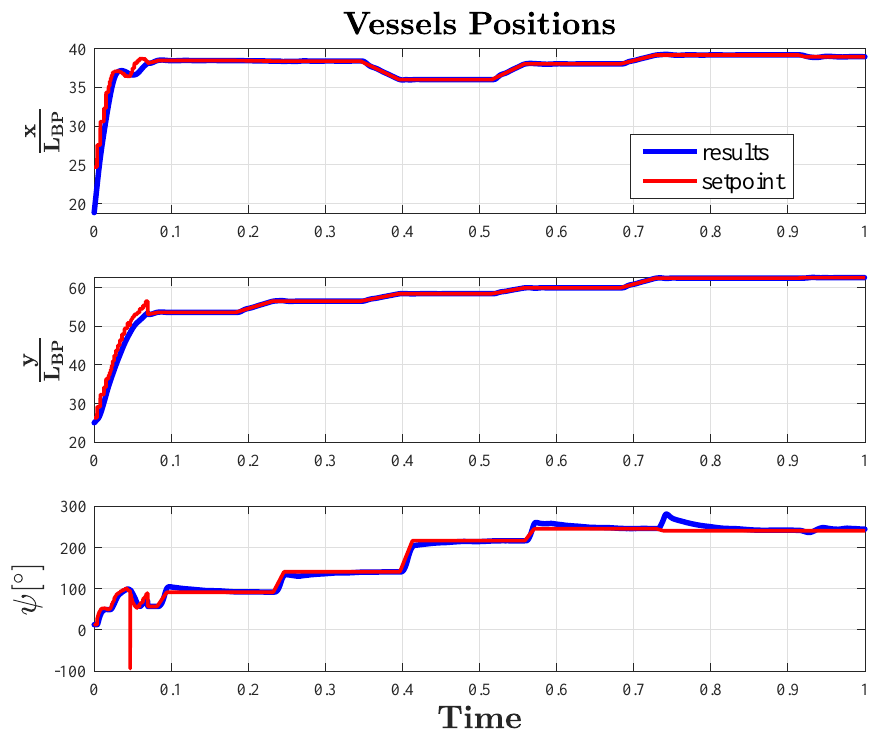
Figure 14. From blue to narrow water: vessel position and attitude.